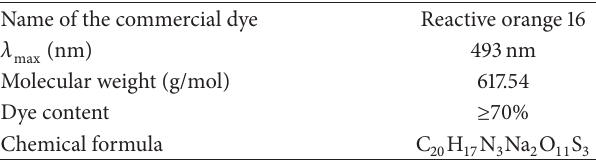
Table 2: General properties of reactive orange